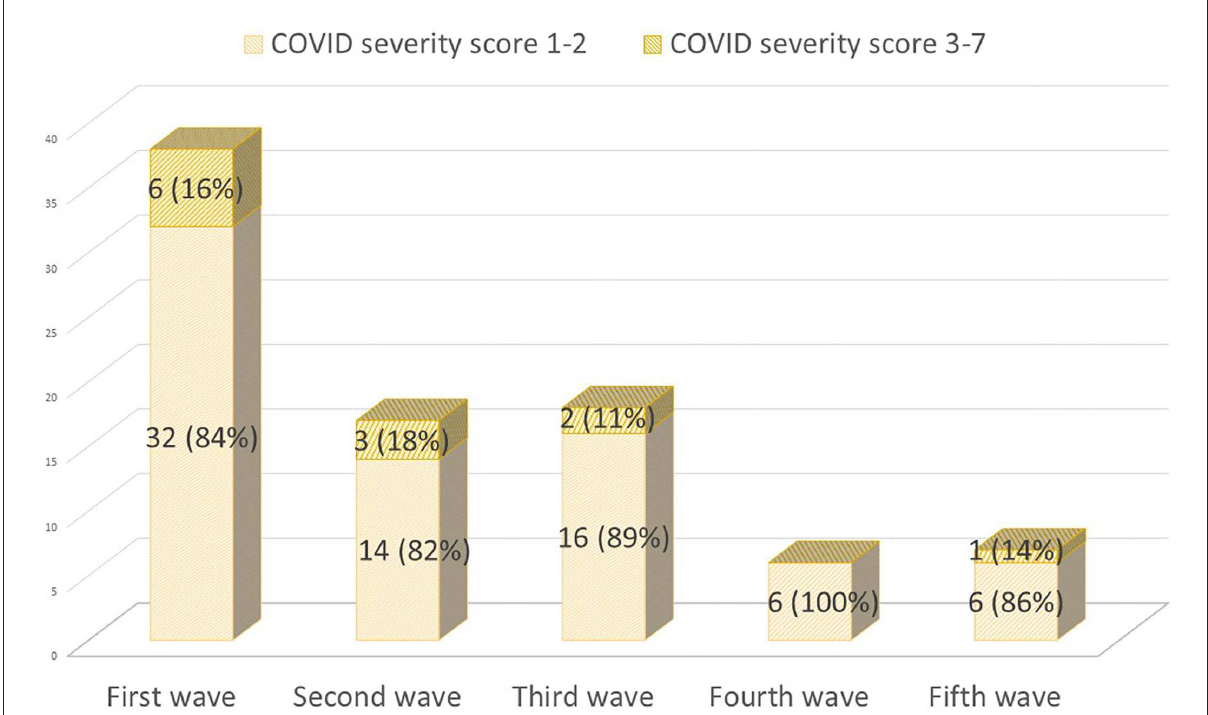
FIGURE3 COVID-19 cases during the first five waves (1 March 2020 to 28 September 2021) classified by their severity [(14); severity scale: 1–2 mild cases; 3–7 severe cases who required